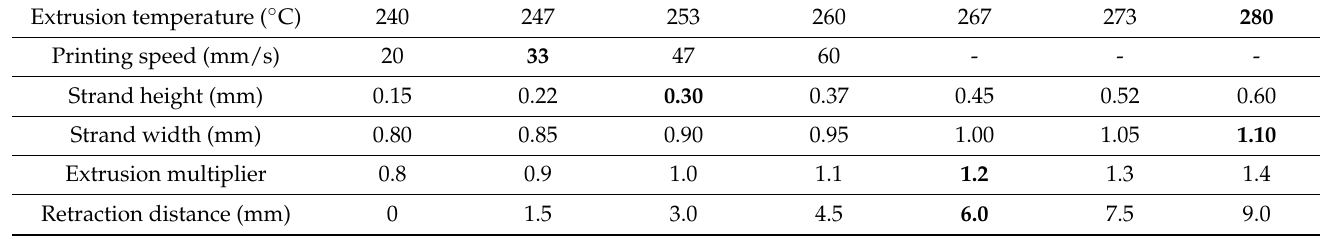
Table 4. List of 3D printing parameters in the FFF processability assessment for PA12 compound with 15 wt% of GNPs and 1 wt% CNTs.